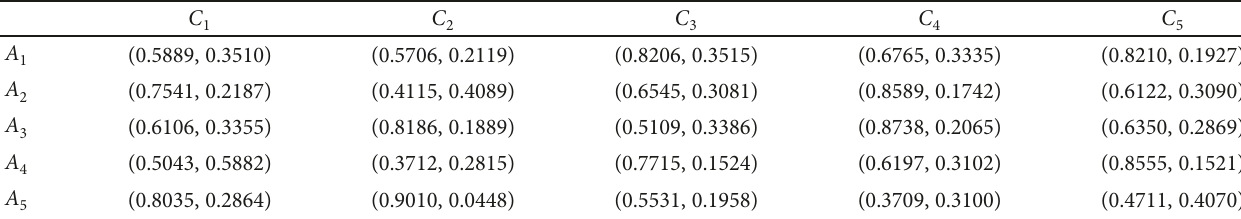
Table 4: Pythagorean fuzzy collective decision matrix D